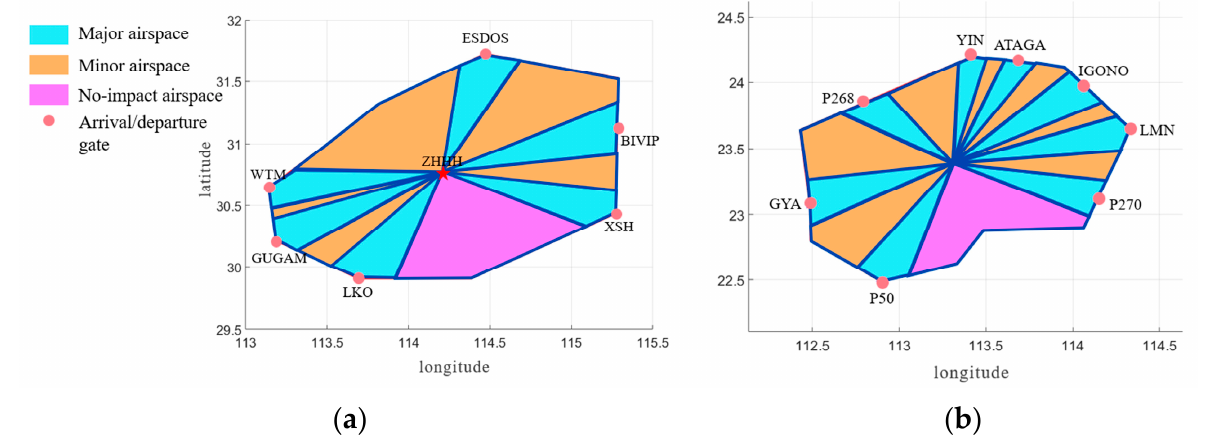
Figure 9. Input features. ( a ) Wuhan terminal area; ( b ) Guangzhou terminal area.